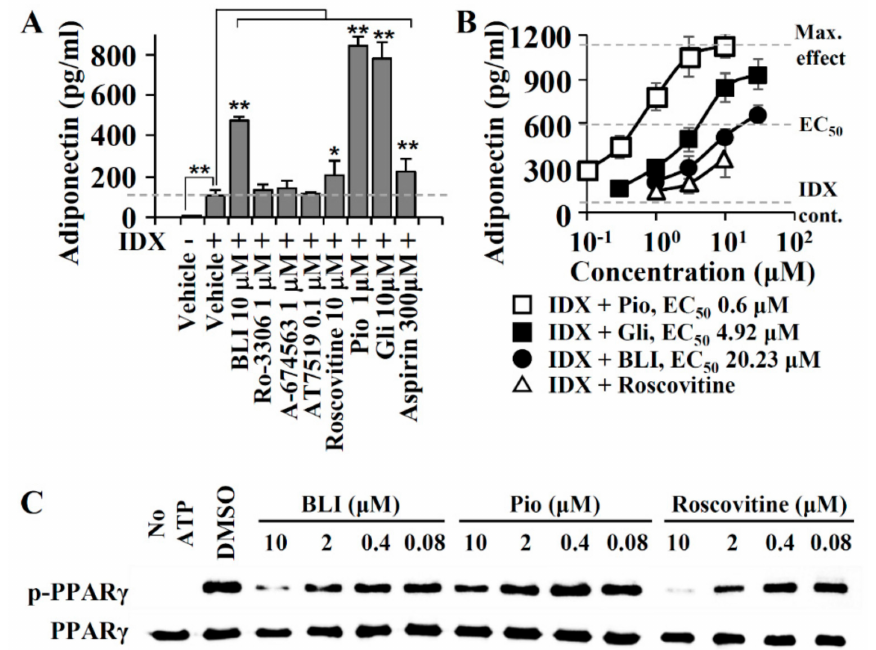
Figure 2. E ff ects of cyclin-dependent kinase (CDK5) inhibitors on adiponectin production during hBM-MSCs. ( A ) CDK inhibitors were added to IDX medium when adipogenic di ff erentiation was induced in hBM-MSCs. On the fifth day, cell culture supernatants were collected and adiponectin level was quantified by ELISA. Pioglitazone (pio), glibenclamide (gli), and aspirin were used as positive controls for the adiponectin production-enhancing activity. Values represent means ± SD ( n = 3); * p ≤ 0.05, ** p ≤ 0.01. ( B ) The half-maximal e ff ective concentration (EC 50 ) values were calculated for butyrolactone I and roscovitine on adiponectin production-enhancing activity. ( C ) Western blot analysis for measuring the inhibition activity against PPAR γ phosphorylation (pPPAR γ ). PPAR γ ligand-binding domain (LBD) was incubated with butyrolactone I (BLI), pioglitazone, or roscovitine at various concentrations in assay bu ff er containing